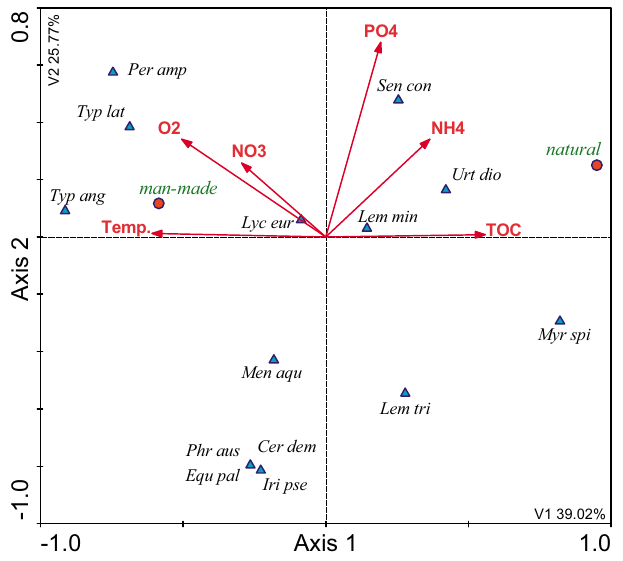
Figure 6. CCA model of dependencies between plant species, the physicochemical variables and type of waterbody.